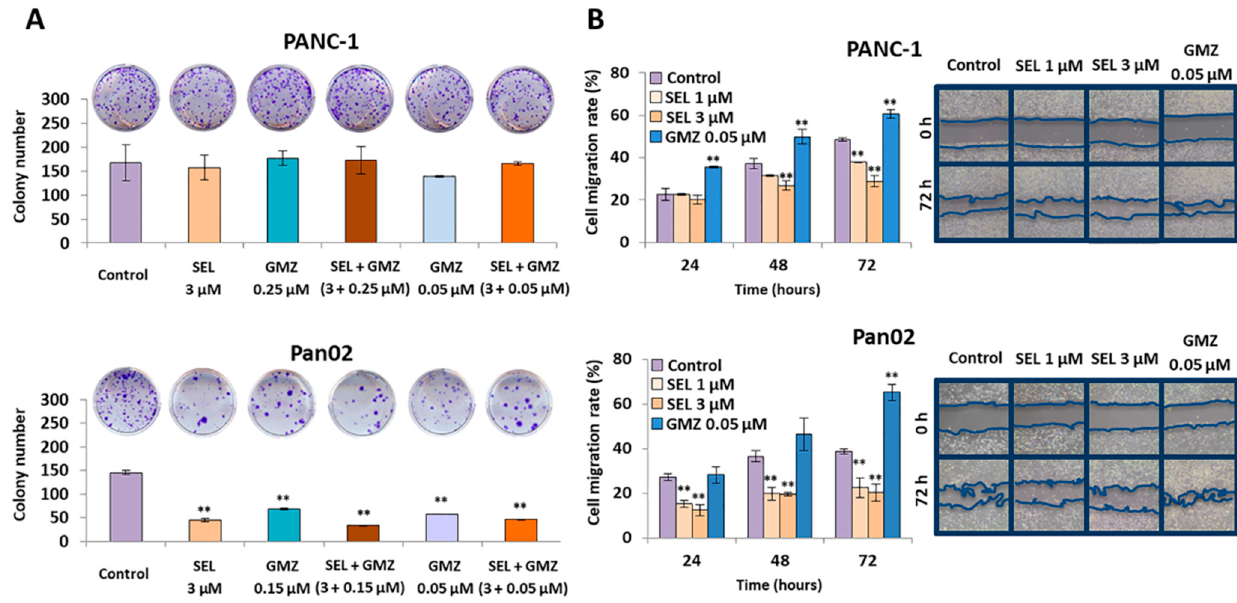
Figure 4. Effect of sodium selenite on colony formation and cell migration capacity. ( A ) Colony growth analysis of PANC-1 and Pan02 after selenite, GMZ and both selenite + GMZ treatment (72 h). ( B ) Cell migration analysis. Representative optical microscopy images and graphical representation of the modulation of migration capacity of PANC-1 and Panc02 cells after exposure to sodium selenite and GMZ at different times (0 and 72 h). All data are presented as mean ± standard deviation of three independent experiments; ** p < 0.01 vs. respective control group. GMZ (gemcitabine); SEL (sodium selenite).